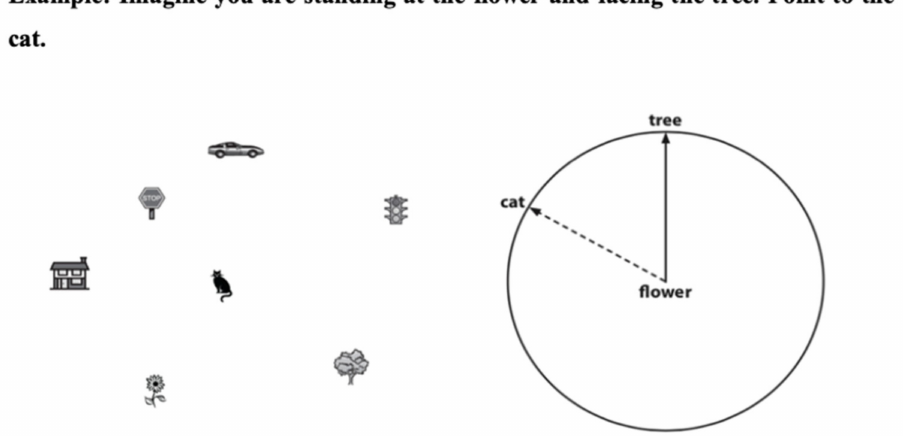
Figure 1. Spatial orientation